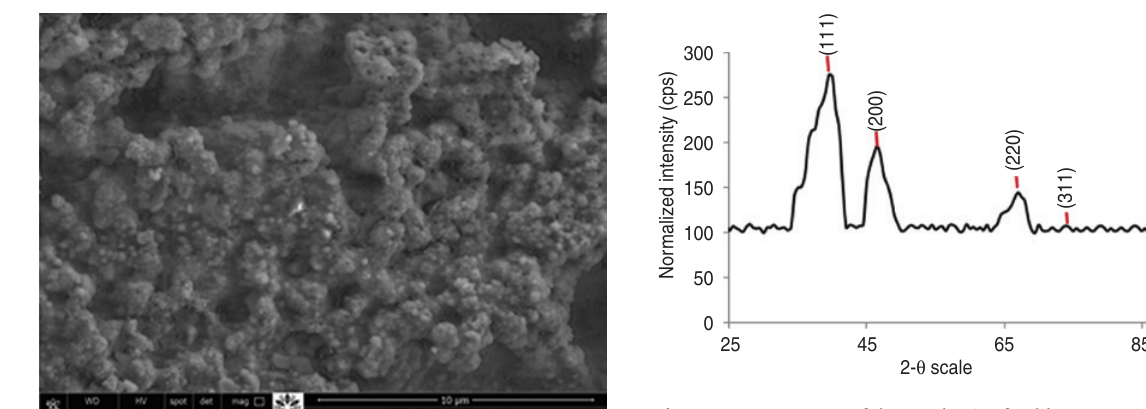
Figure 9: XRD pattern of the synthesis of gold